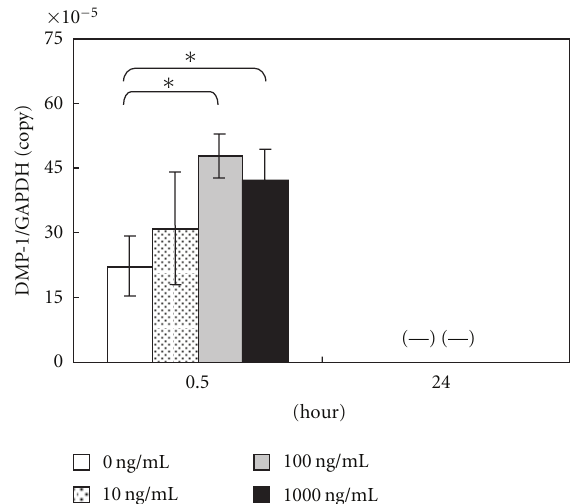
Figure 5: Graph of DMP-1 copy number determined using LightCycler. Data represent means ± SD in five samples in three separate experiments. (—) means not detectable. Significantly di ff erent from control values ( ∗ P < 0 .